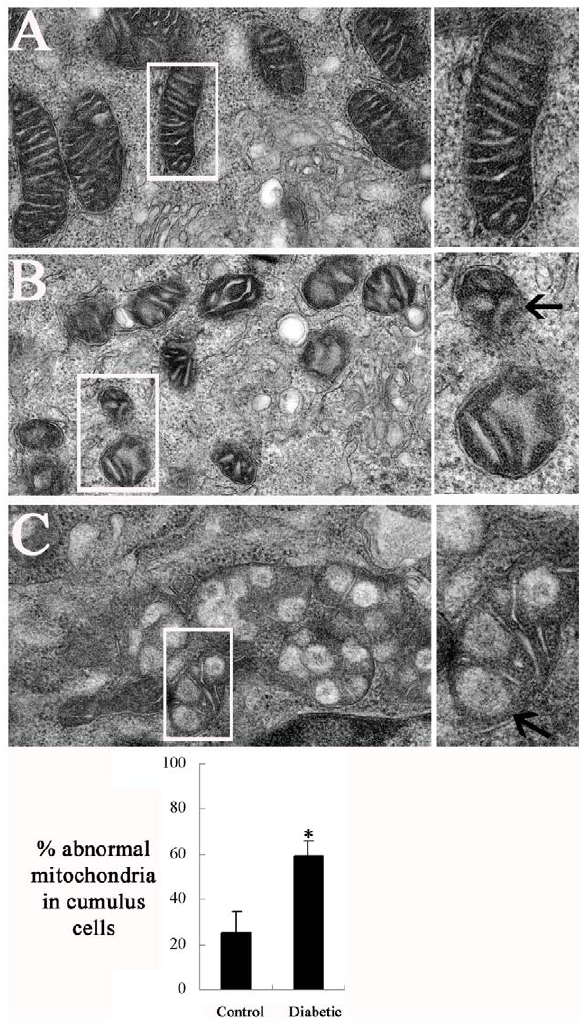
Figure 1. Altered mitochondrial morphology in cumulus cells of diabetic mice. Cumulus-oocyte complexes collected from control and diabetic mice were subjected to transmission electron microscopy analysis and mitochondrial structure was compared. (A) Representative electron micrograph of mitochondria from control cumulus cells, showing bean-shaped structures with numerous transversely orientated cristae enveloped by an intact outer membrane; (B–C) Representative electron micrographs show alterations in mitochondrial morphology of diabetic cumulus cells: (B) small spherical mitochondria with fewer and disarrayed cristae and a decreased electron density of the matrix (arrow), and (C) mitochondria with membrane rupture or large vacuoles (arrow). Higher magnification views of boxed regions are also presented (right panel). (D) Quantification analyses of abnormal mitochondria in cumulus cells from control and diabetic mice. Data are presented as mean percentage of abnormal mitochondria 6 SD in total examined mitochondria. * p , 0.05 vs